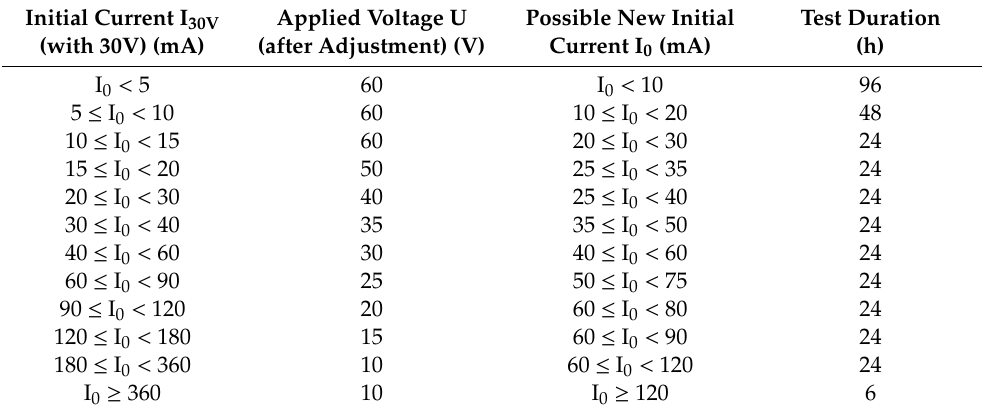
Figure 7. NT BUILD 492 test set-up. Table 7. Test voltage and duration for concrete specimen with normal binder content [17,30–33].